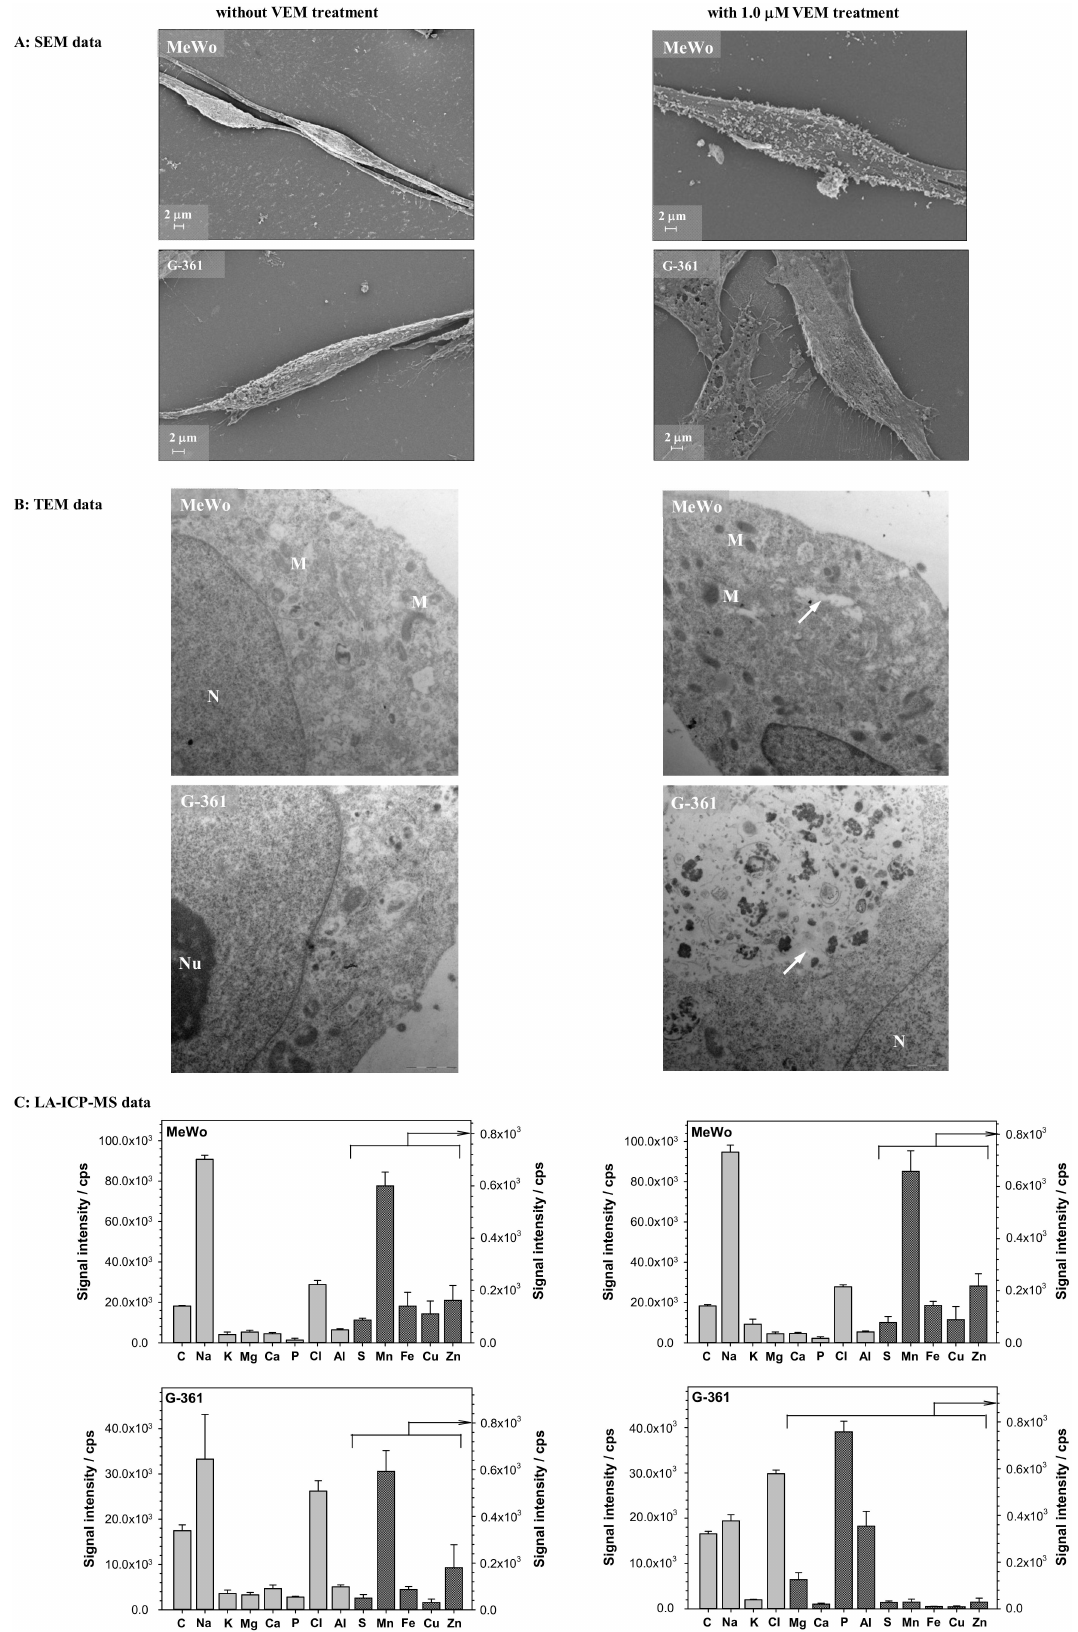
Figure 6. SEM ( A ), TEM ( B ) images, and LA-ICP-MS analysis ( C ) of melanoma cells without and with BRAF mutation before and after exposure to VEM